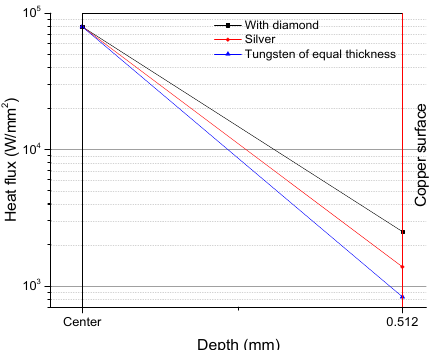
Figure 8. Variations in the heat flux of anodes: type (a) is black line; type (c) is blue line; type (d) is red line.